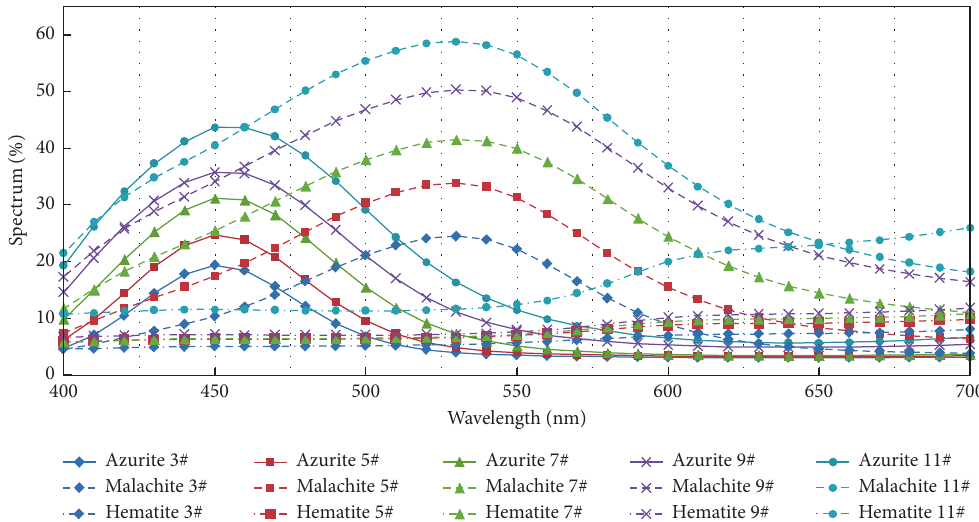
Figure 3: Visible spectral reflectance of three commonly used pigments. Identifiers, 3#, 5#, 7#, 9#, and 11#, are the size degrees of the pigments.